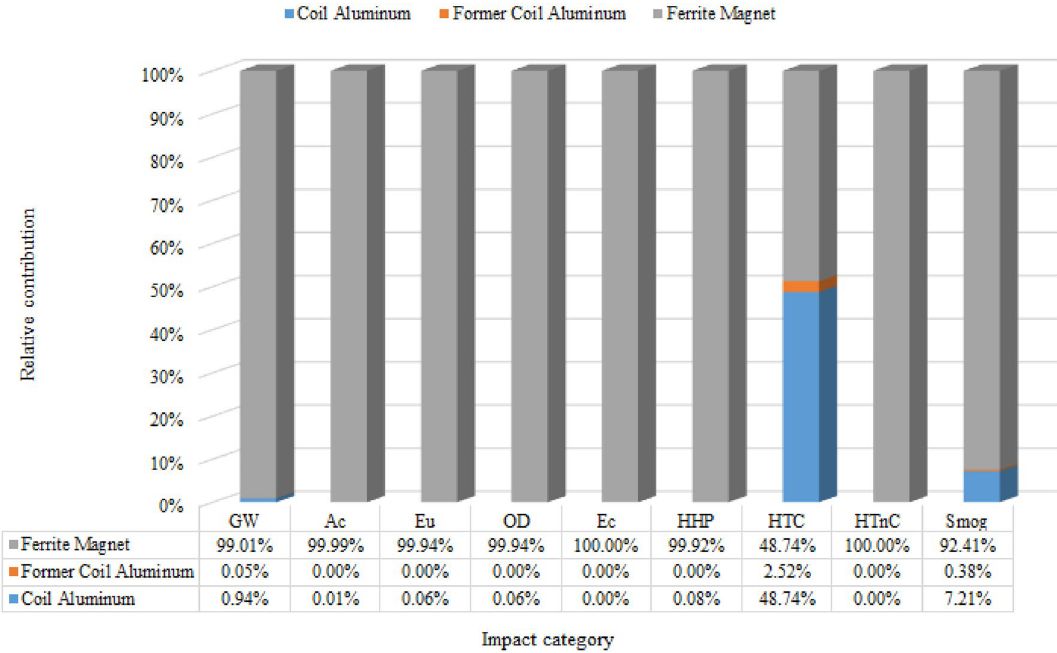
Figure 3. Bar graph with two axes and the three materials representing the relative contribution in percentage by impact category by categories, highlighting the HTC aluminum coil category with the highest percentage.